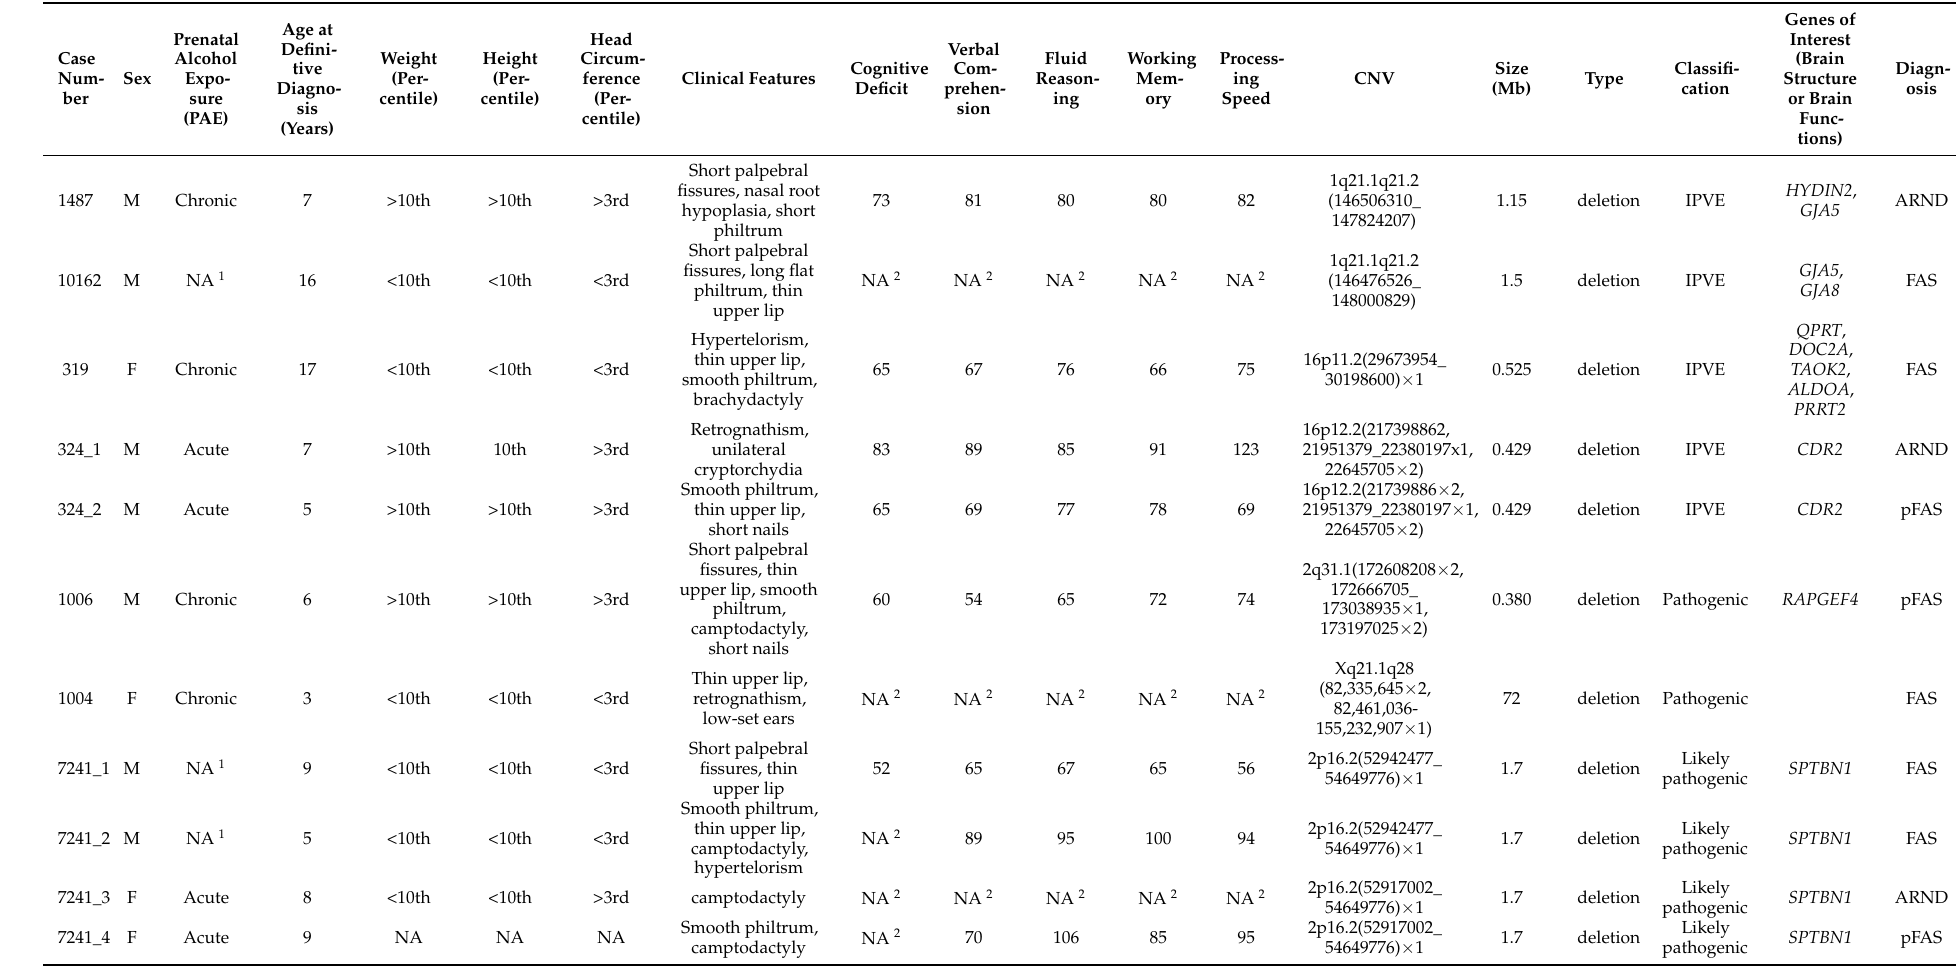
Table 1. Description of clinical phenotype and CNVs found in our series of FASD